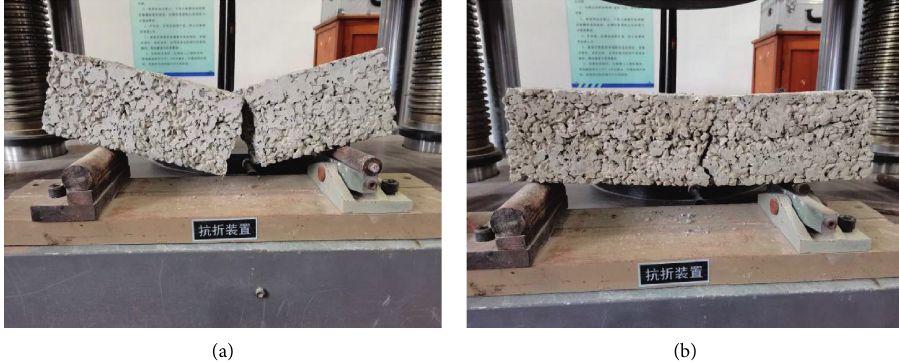
Figure 10: Macroscopic damage pattern of RCCAPC and fiber-reinforced RCCAPC in bending test. (a) RCCA